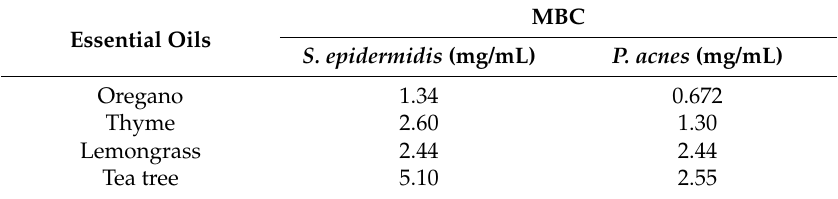
Table 2. Minimal bactericidal concentrations (MBC) of the selected EOs against S. epidermidis and P. acnes .